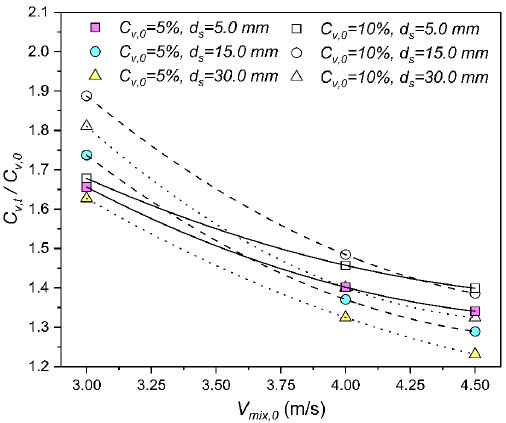
Figure 17. Relationship between initial mixture velocity and retention ratio.